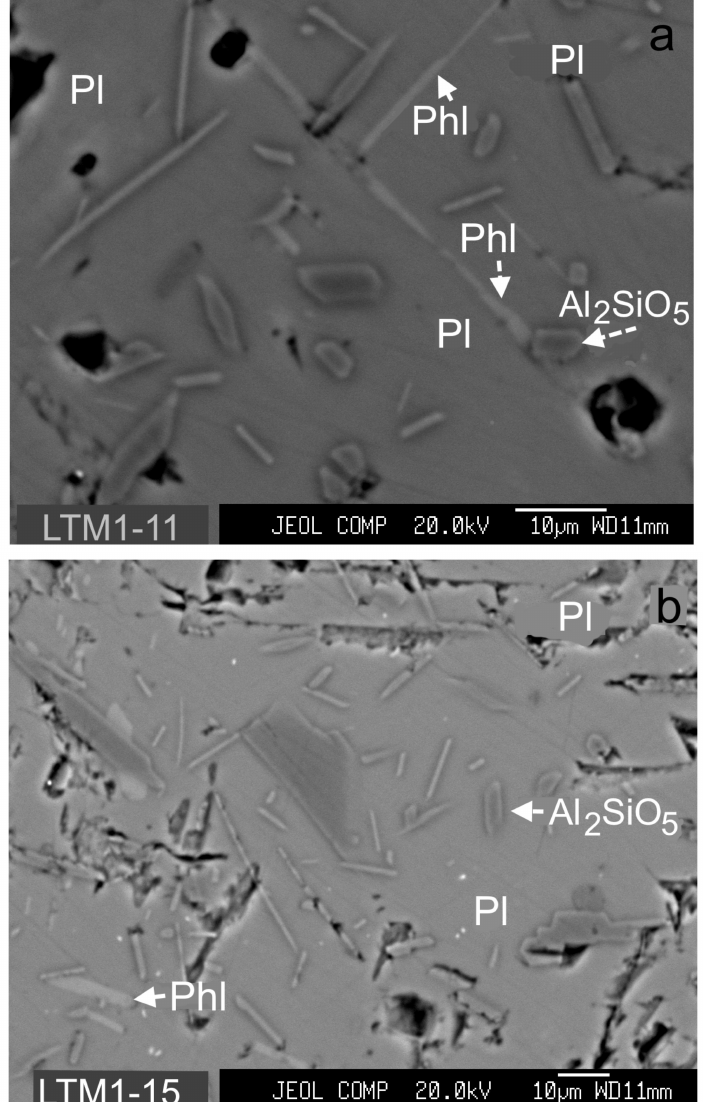
Figure 11. ( a , b ). Micrometer-sized lamellae and inclusions of phlogopite (Phl) and Al 2 SiO 5 hosted by plagioclase (Pl) which occurs at the margin of grains of orthopyroxene in the Lotmvara-I sill. The location of these samples, Ltm1-11 and 15 (Figure 6a,c), is shown in Figure